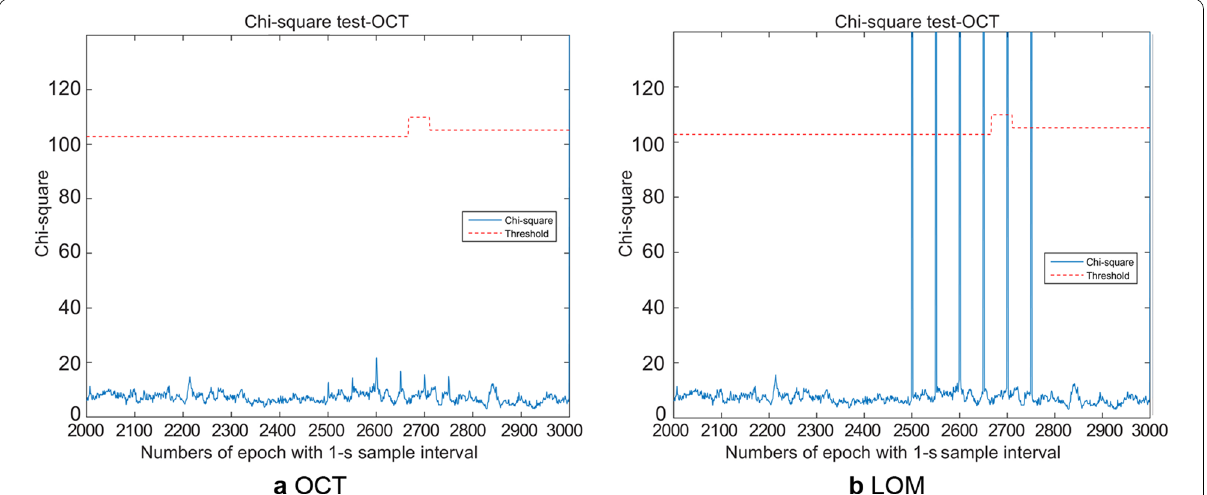
Fig. 8 OCT and LOM Chi‑square test statistics for fault detection; equations from (Teunissen 1990) and (Wieser 2004) was adopted; code and carrier‑phase measurements were processed together to compute these test statistics; P FA